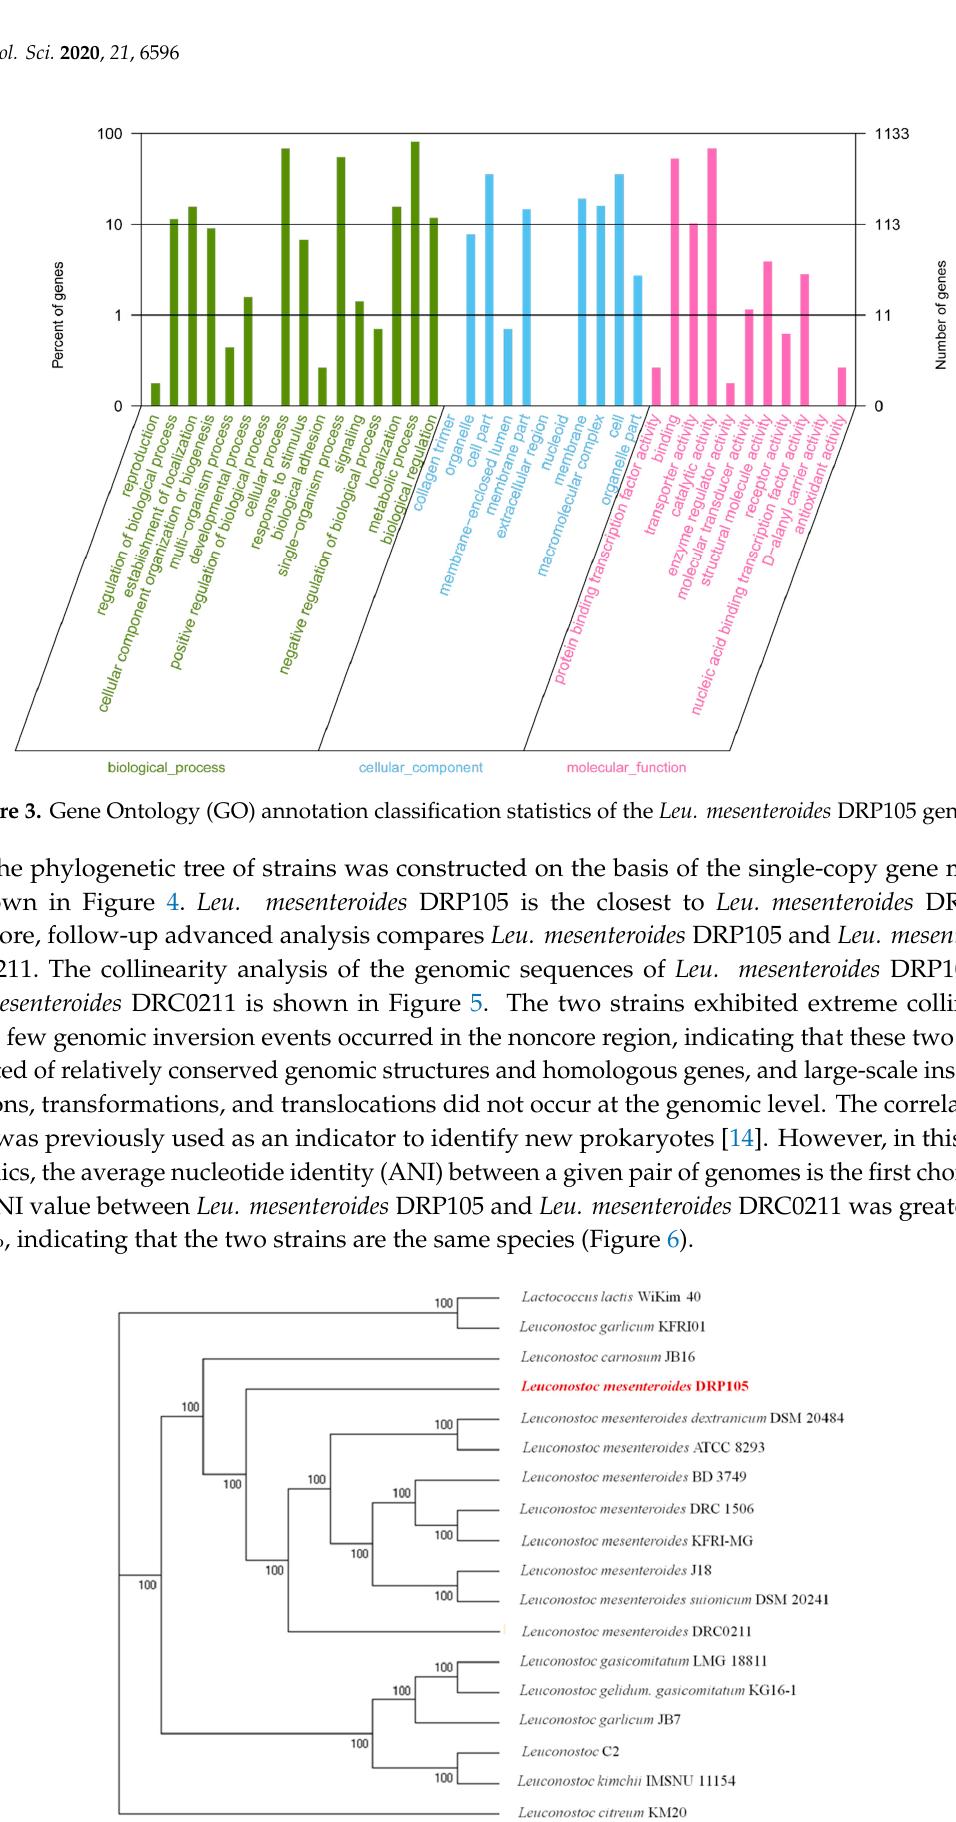
Figure 4. A molecular phylogenetic tree constructed using the maximum-likelihood method.